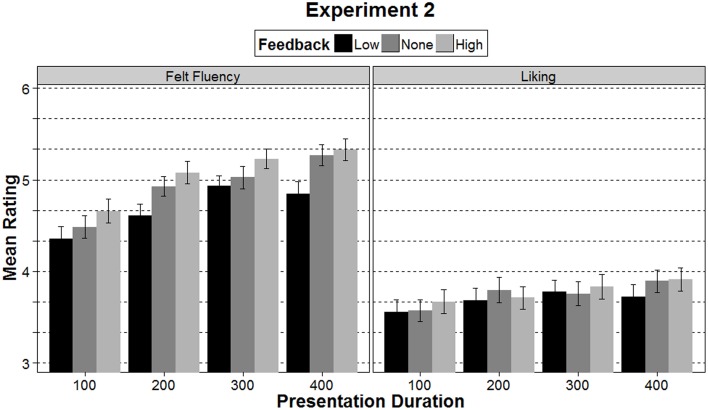
Mean ratings of felt fluency and liking in Experiment 2 separately for the three feedback conditions and the four presentation durations. Error bars represent ±1 SE.